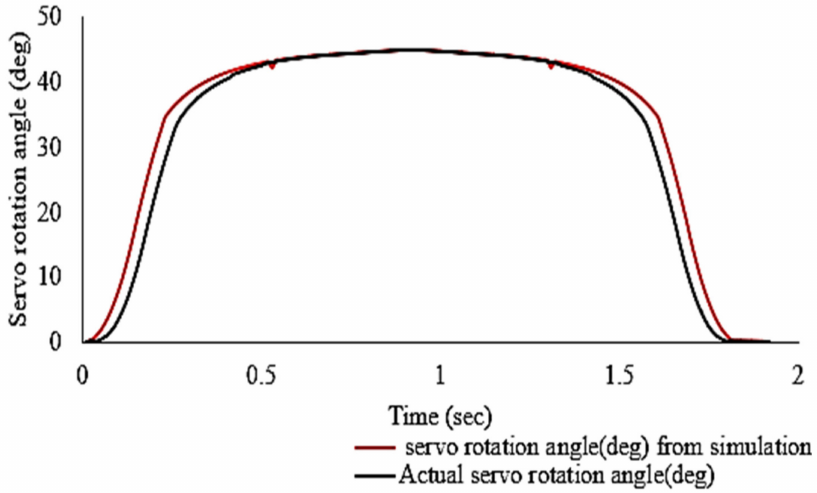
Figure 9. Comparison between experimental and simulation